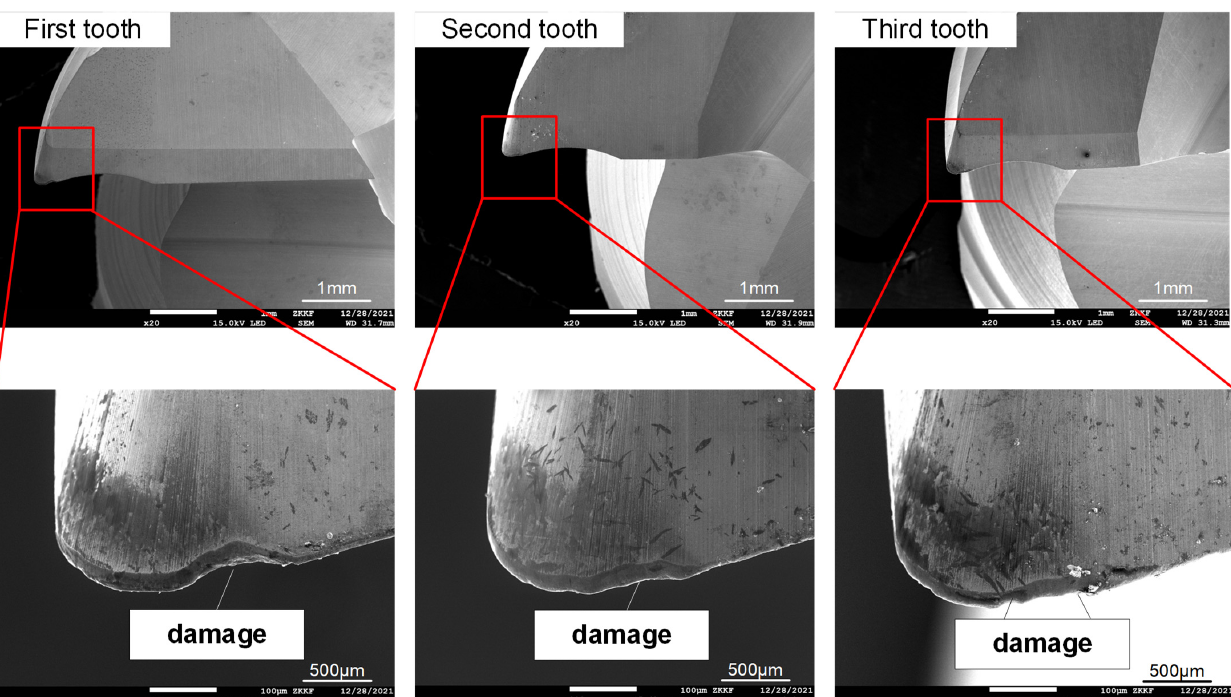
Figure 14. SEM images of cutting-edge wear in the case of QC-2803.